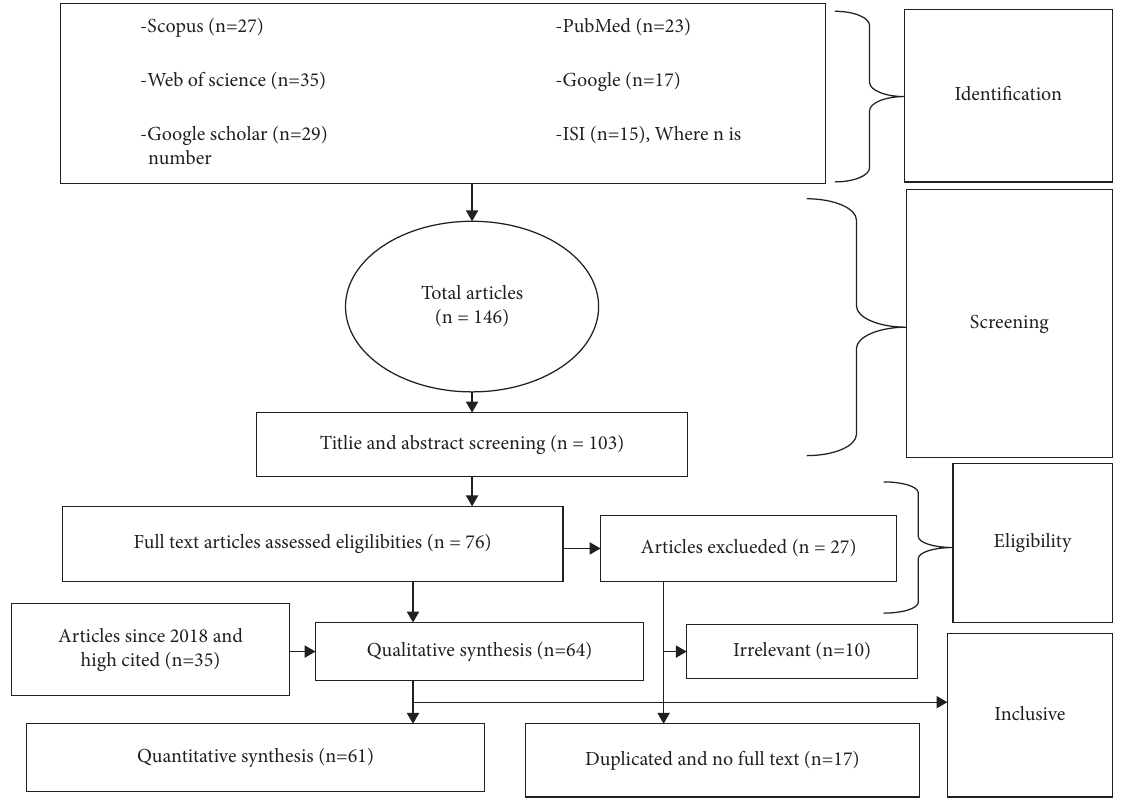
Figure 1: Flow diagram of the studies screening selection based on inclusive and exclusive